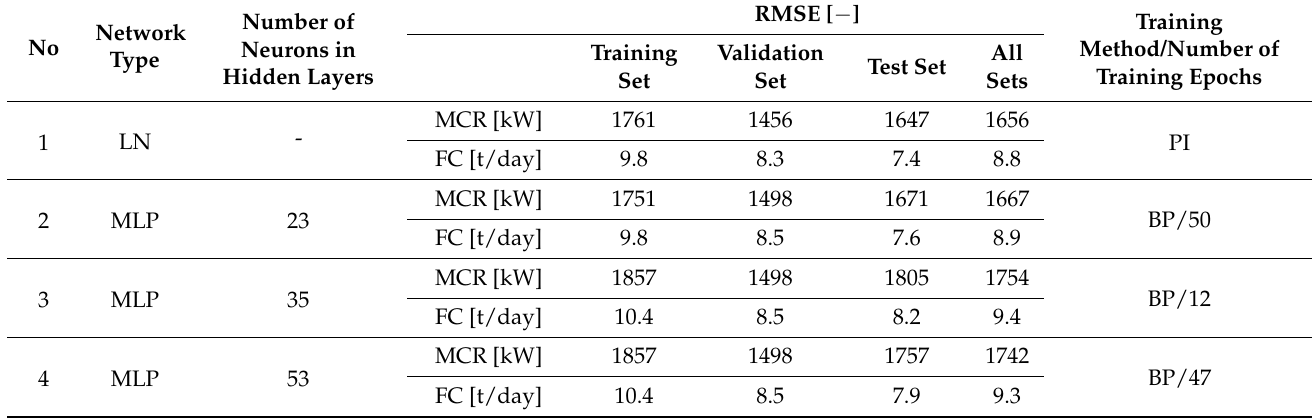
Table 5. An overview of the neural networks that were developed to estimate the engine power and fuel consumption of tankers, where: BP—error back propagation algorithm, CG—conjugate gradient algorithm, PI—pseudo-inverse algorithm and RMSE—root mean square